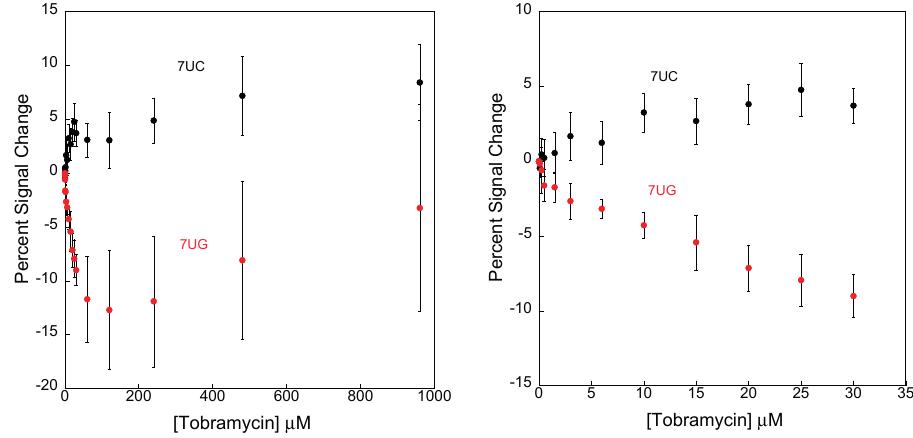
Figure 4. ( Left ) The aptamers with mutated binding sites, 7UG and 7UC, did not